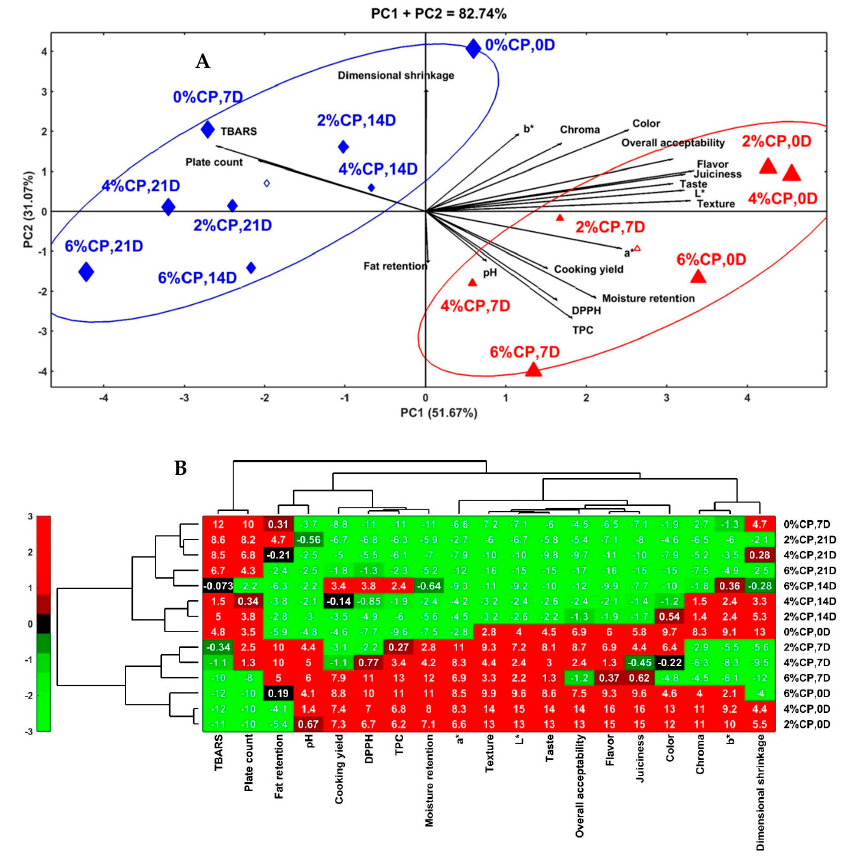
Figure 1. Principle component analysis (PCA) biplot ( A ) and hierarchical clustering analysis (HCA) heatmap ( B ) of the physicochemical and sensory-quality attributes of beef burger formulated with 0, 2, 4, and 6% clove powder, and stored at 4 °C for 0, 7, 14, and 21 days. In the heatmap, the red color indicates high linkage (positive relation), and green indicates low linkage (negative relation).